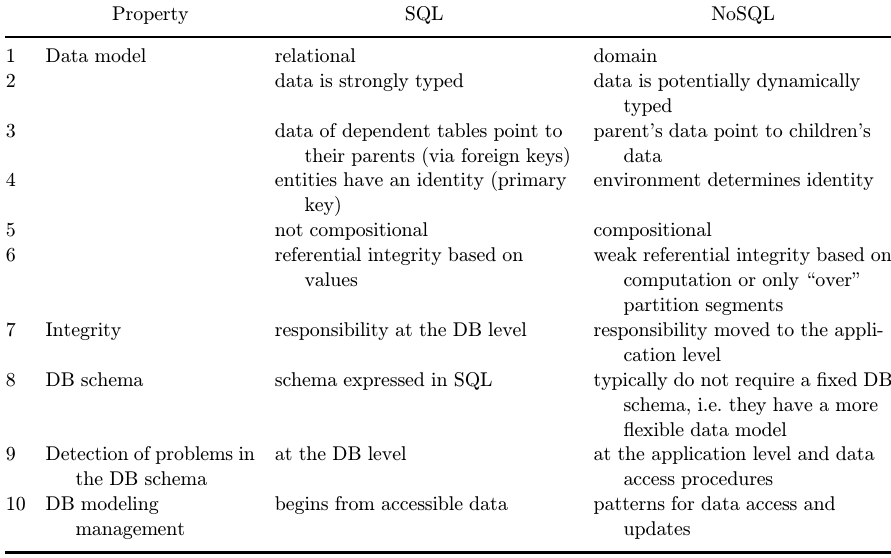
Table 1. Comparison of relational and NoSQL